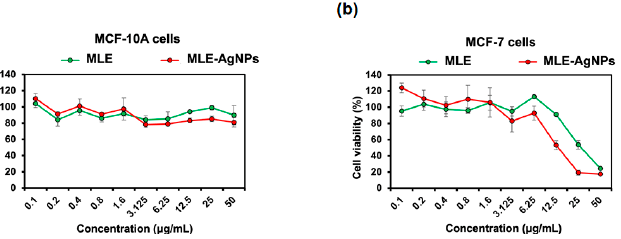
Figure 5. Cell viability of MCF-10A ( a ) and MCF-7 ( b ) cell lines in response to MLE and MLE-AgNPs treatments. The potential applications of plant-mediated AgNPs in breast cancer treatments have been the subject of extensive research. Plant-mediated AgNPs using aqueous garlic, green tea and turmeric extracts were reported for anticancer activity against human cancer cell lines including breast cancer cells (MCF-7). The IC 50 values for these plant-mediated AgNPs ranged from 12 to 20 μ g/mL, indicating their efficacy in killing MCF-7 cells [49]. In addition, green AgNPs synthesized from Cynara scolymus leaf extract in conjunction